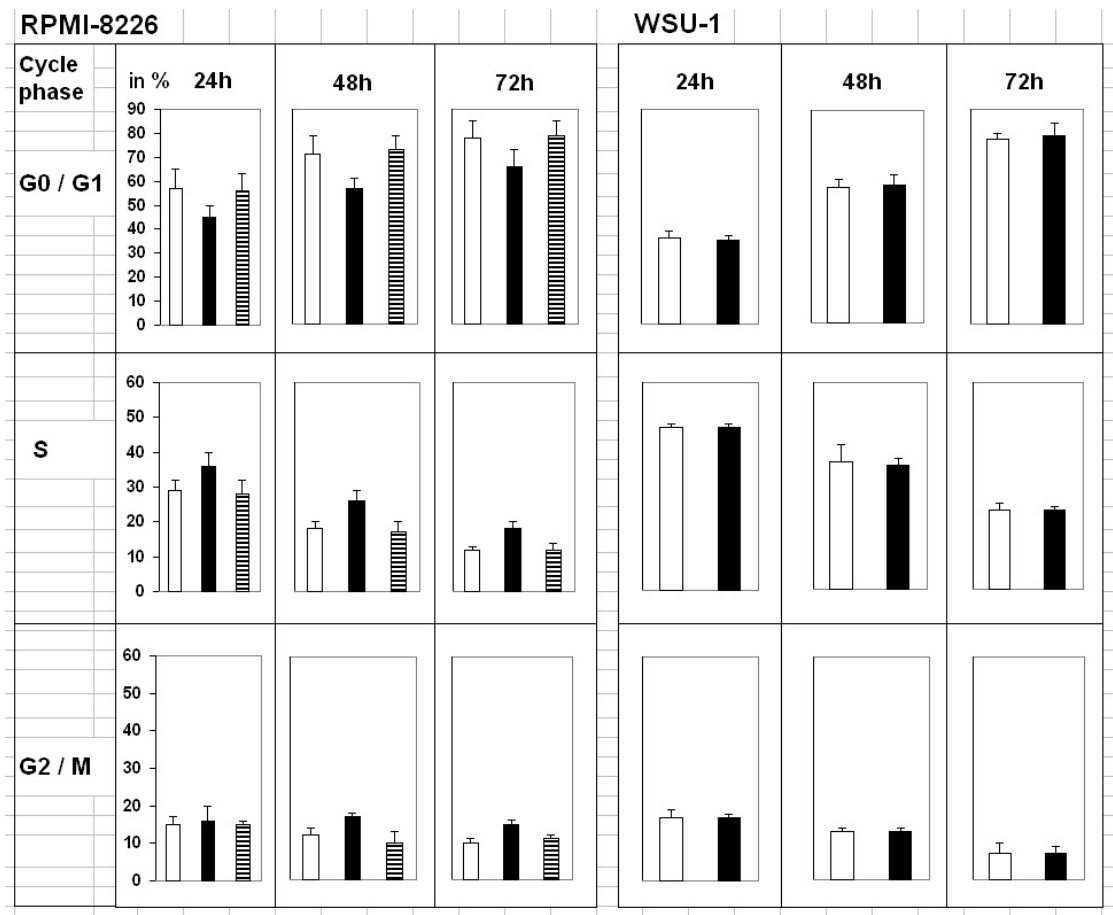
FIGURE 3. Cell cycle analysis of MM cell line RPMI-8226 and B cell lymphoma cell line WSU-1. The cells were incubated with IL-6 (5 ng/10 6 cells/ml) or with IL-6RA (0.2 μ g/10 6 cells/ml) for 24, 48, or 72 h. IL-6RA was added 24 h before. The cell cycle phases G0/G1, S, G2/M were assessed using the cycle test plus DNA reagent kit. The values are the mean + SD of four independent experiments expressed in percentage of total cell number. Untreated (Open), IL-6 (Closed), IL-6RA (Cross-hatch).